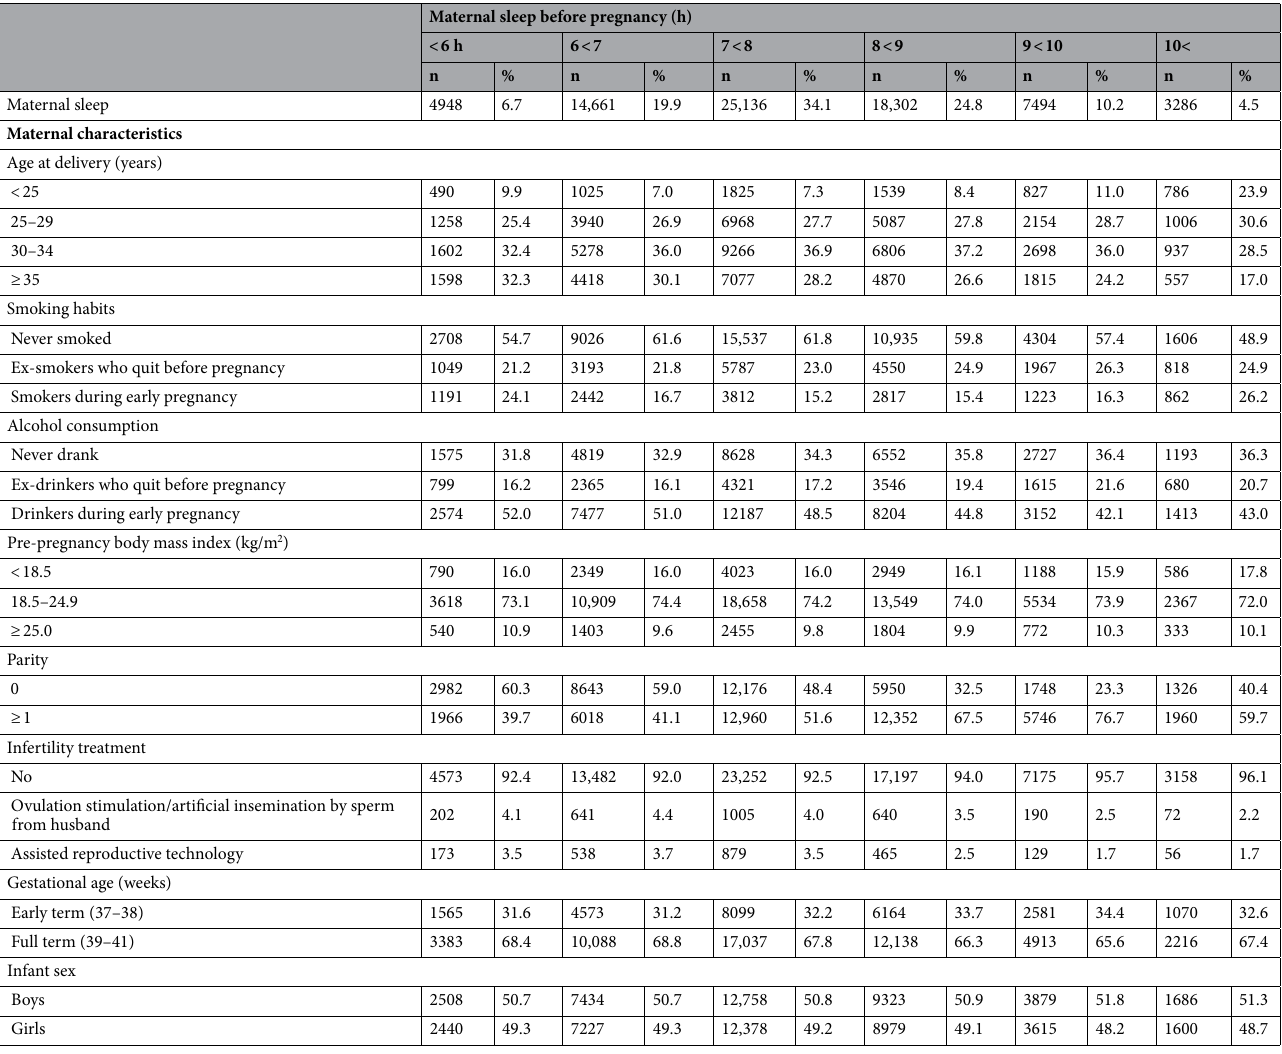
Table 1. Baseline characteristics of the study population stratified by sleep duration before